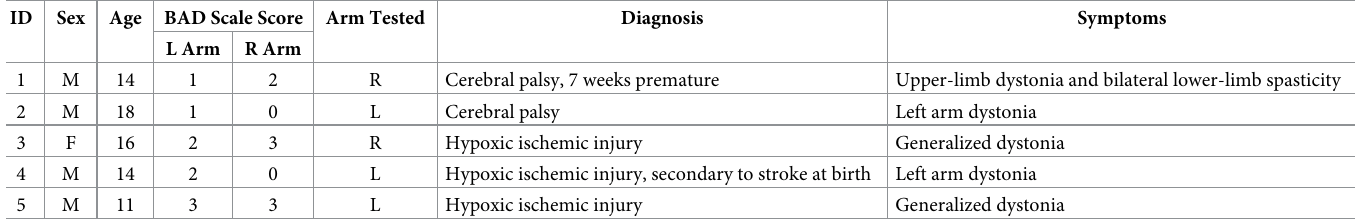
Abbreviations: BAD Scale, Barry-Albright Dystonia Scale; F, female; L Arm, severity of left arm; M, male; R Arm, severity of right arm. Scores are based on the